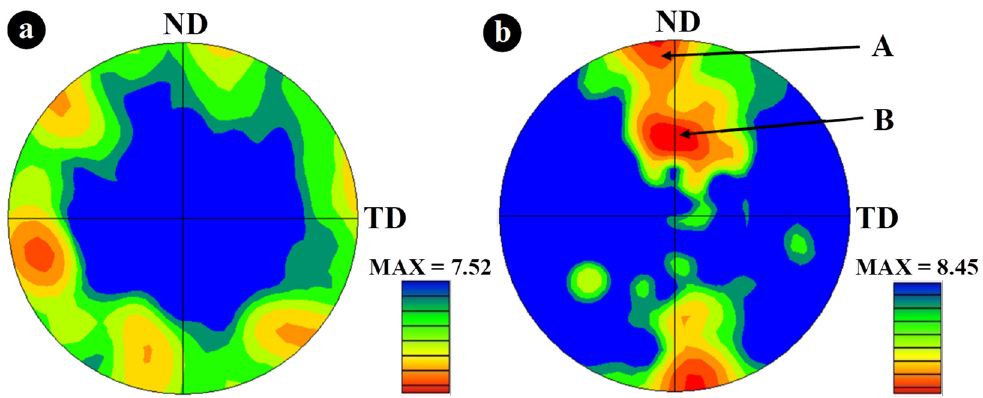
Figure 7. The (0 0 0 1) pole figures for α -Mg phase in ( a ) C-as-extruded and ( b ) C-6 P at 593 K.